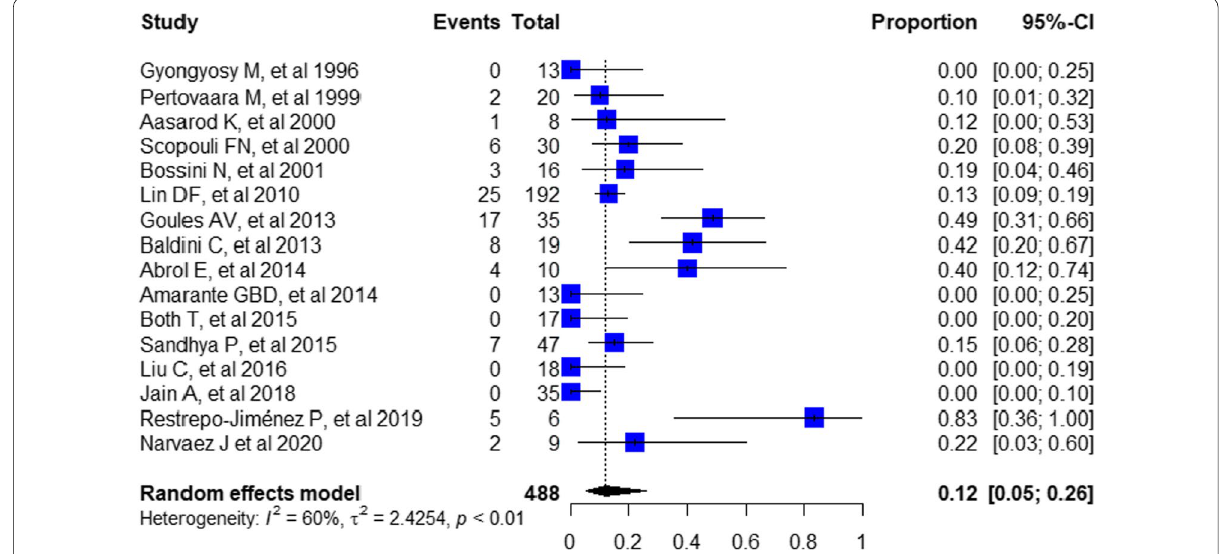
Fig. 14 Meta‑analysis of the Glomerulonephritis in patients with Sjogren’s